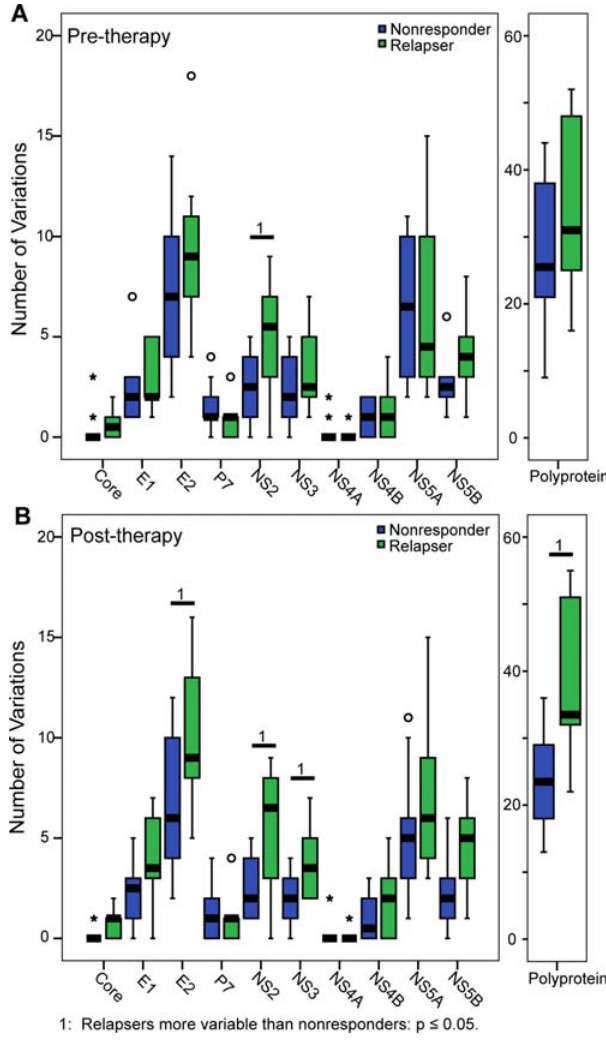
Figure 2. Unique amino acid variability among nonresponders and relapsers. Amino acid variations found exclusively in one response class but not in the other were compared between nonresponders and relapsers. Statistical significance of the difference in the number of variations was compared using the Mann-Whitney test. A) Pre-therapy. B) Post-therapy. The line represents the median value, and the box represents the 25–75% range. Whiskers represent samples within 1.5 box lengths, and the u and * represent outliers between 1.5 and 3 box lengths and beyond 3 box lengths respectively.